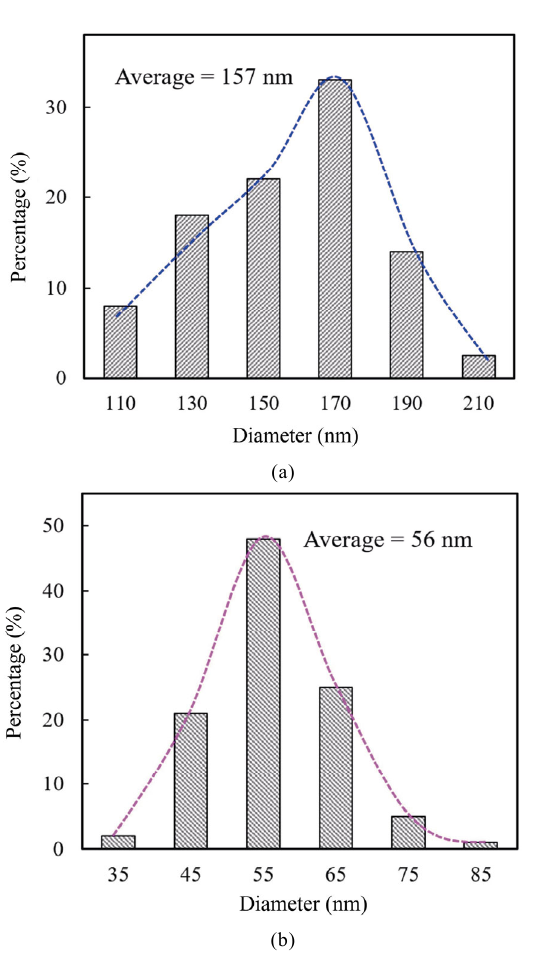
Fig. 3 Diameter distributions of HAP nanofibers on two eroded enamel surfaces: (a) CAS-AG eroded; (b) CAS-XG eroded.